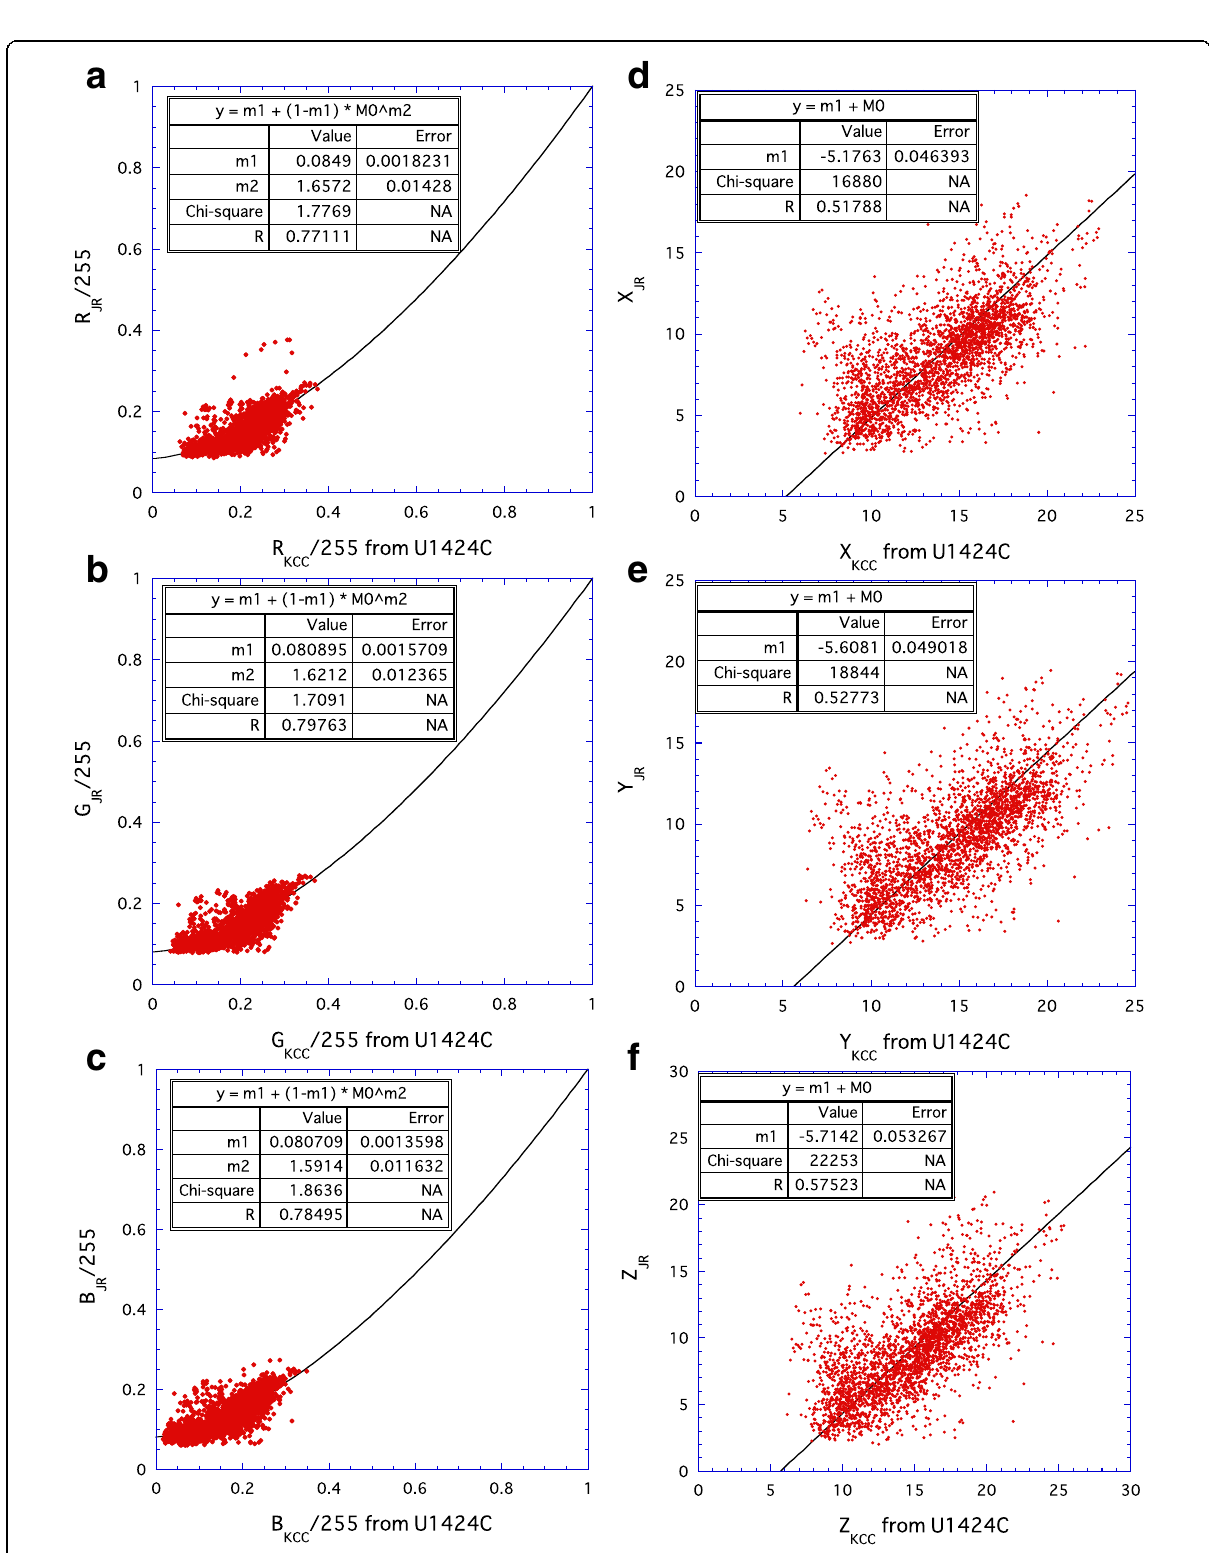
Fig. 7 Relationships between shipboard R ( a ), G ( b ), and B ( c ) and those measured at Kochi Core Center (KCC) and between shipboard X ( d ), Y ( e ), and Z ( f ) and those measured at